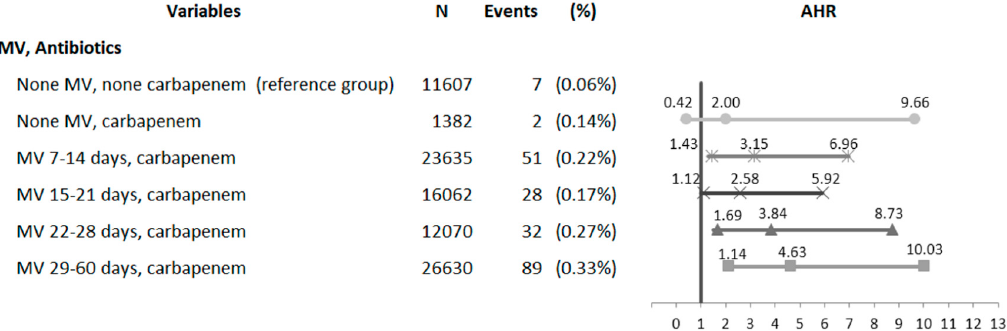
Table 3. Subgroup analysis of the interaction between carbapenem therapy and mechanical ventilation support for C. difficile infection in critically ill ICU patients.